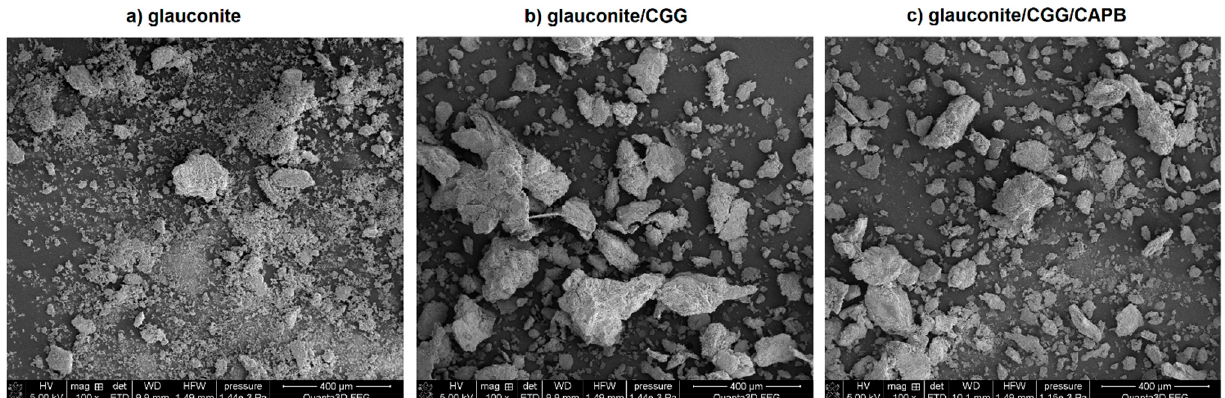
Figure 9 . SEM micrographs differences in the morphology of glauconite before and after the adsorption of CGG and CGG with CAPB: ( a ) pure glauconite, ( b ) glauconite/CGG, ( c ) glauconite/CGG/CAPB; magnification ×100.